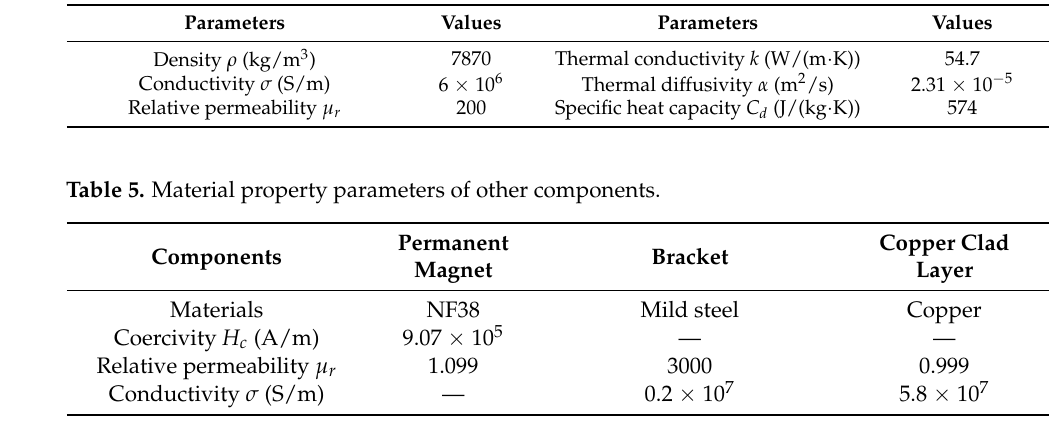
Table 4. Material property parameters of rotor drum.